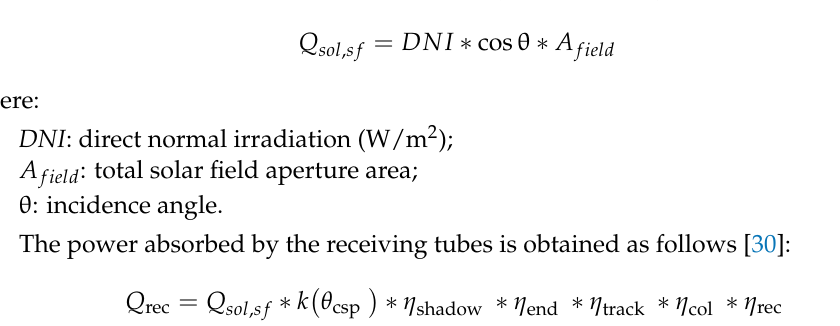
Figure 2. ( a ) Parabolic trough collector structure. ( b ) The heat exchanges of the absorber . The reflected solar power can be obtained by the following equation [30]: